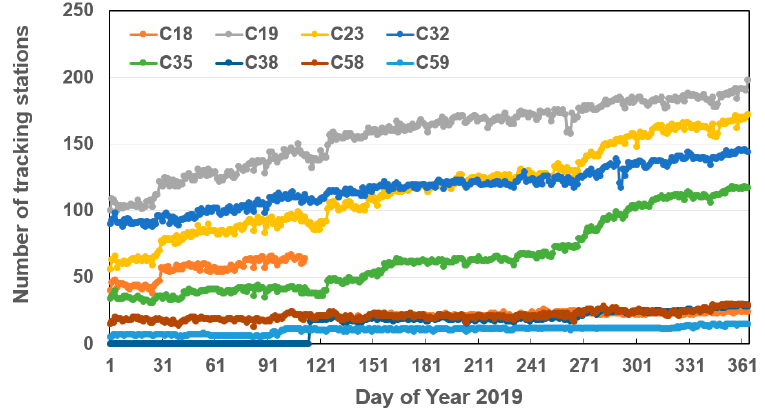
Figure 2. The number of stations with tracking capacity of the BDS-3 representative satellites, i.e., C19, C23, C32, C35, C38, and C59 satellites from DOY 1 to 365, 2019.